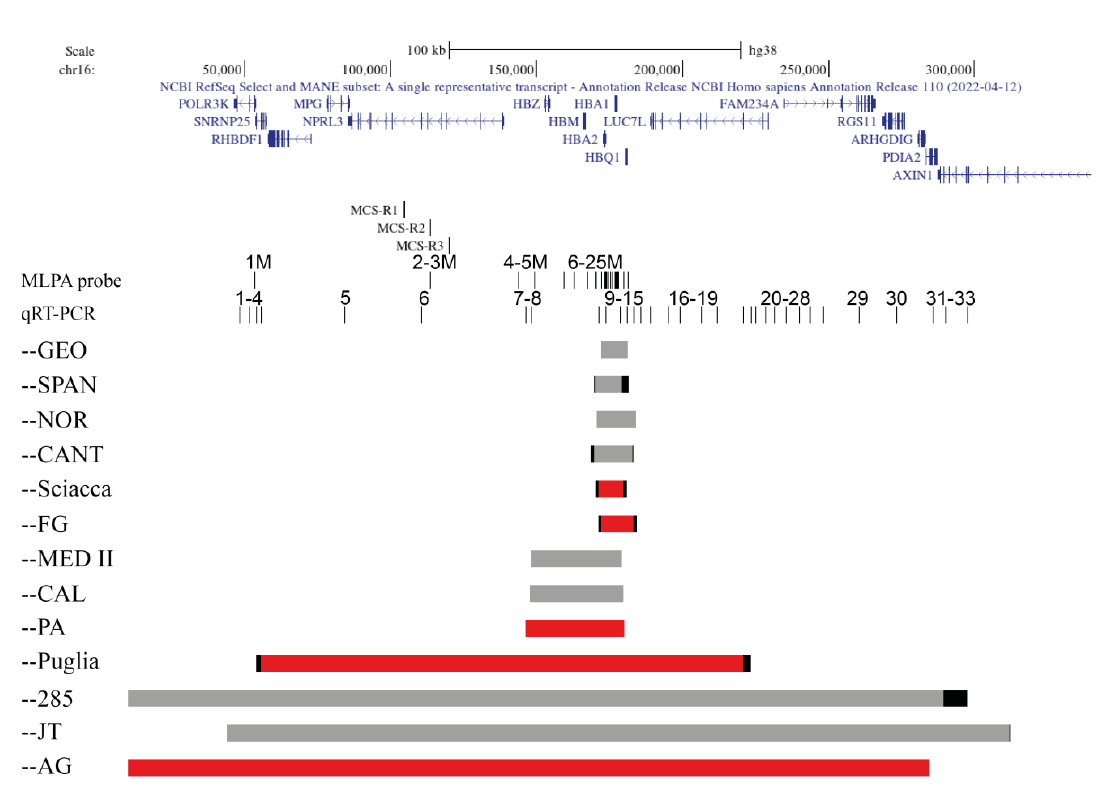
Figure 1. Scheme of the telomeric region on chromosome 16 containing the α -globin gene cluster. In the upper part are reported the genes and the MCS-R, then the location of the MLPA probes (indicated with numbers followed by the letter M) and of the quantitative real-time PCR fragments (indicated with numbers). The five new deletions (--Sciacca, --FG, --PA, --Puglia, and --AG) are indicated in red, the deletions already described are indicated in grey, and the undefined region are in black. Four known deletions --GEO, --SPAN, --NOR, and --CANT are compared with the new deletions --Sciacca and --FG. --PA is compared with two known deletions --MED II and --CAL. The --AG is compared with the --285 and the --JT deletions.